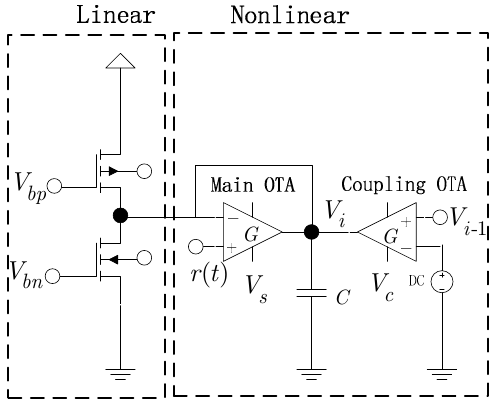
Figure 3. Circuit of an overdamped nonlinear oscillator, which can be an element of a unidirectionally coupled, overdamped nonlinear oscillator ring.